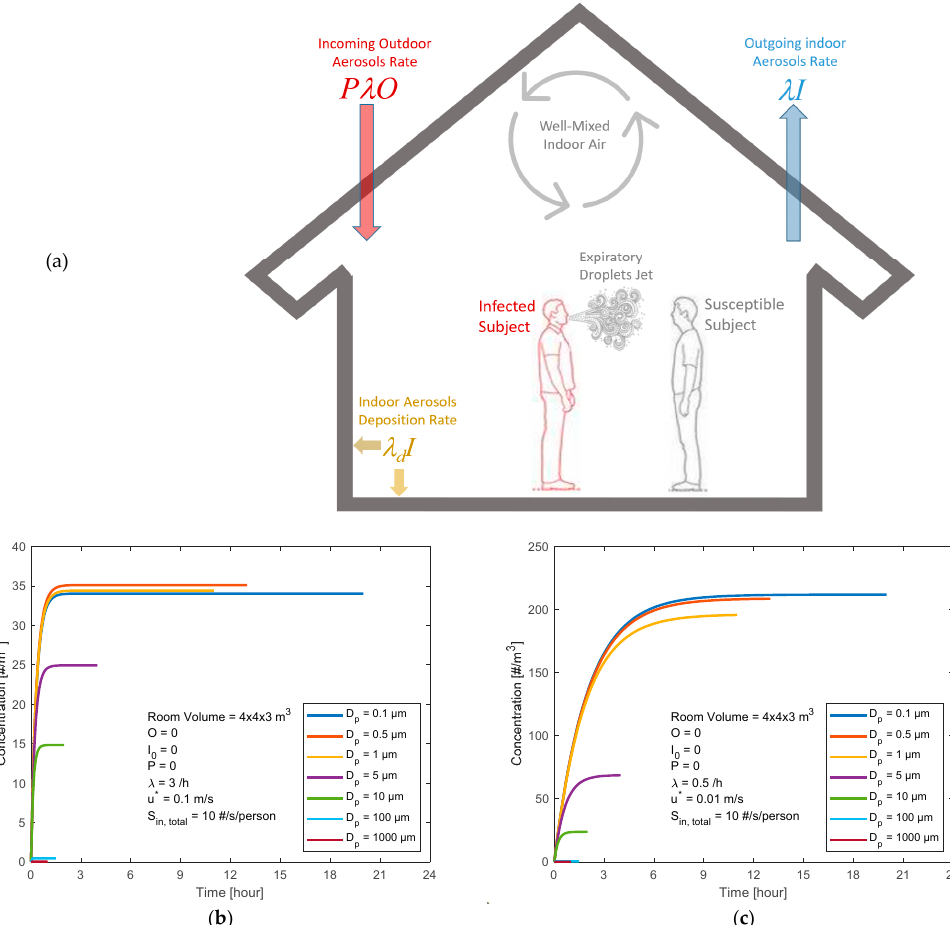
Figure 2. A room occupied by an infected person emitting expiratory particles. ( a ) A scenario sketch and the indoor infectious virus particles concentrations as a function of their diameter and of time for ( b ) a well-ventilated room (high ventilation rate λ = 3 h − 1 and low friction velocity u* = 0.1 m/s) and ( c ) a tightly closed room (low ventilation rate λ = 0.5 h − 1 and low friction velocity u* = 0.01 m/s). The total number of emitted viruses (Sin, total = 10 viruses/s) was assumed to be uniformly distributed on the particles, with an equal number for all particle sizes (7 size bins in the range of 0.1–1000 µm).